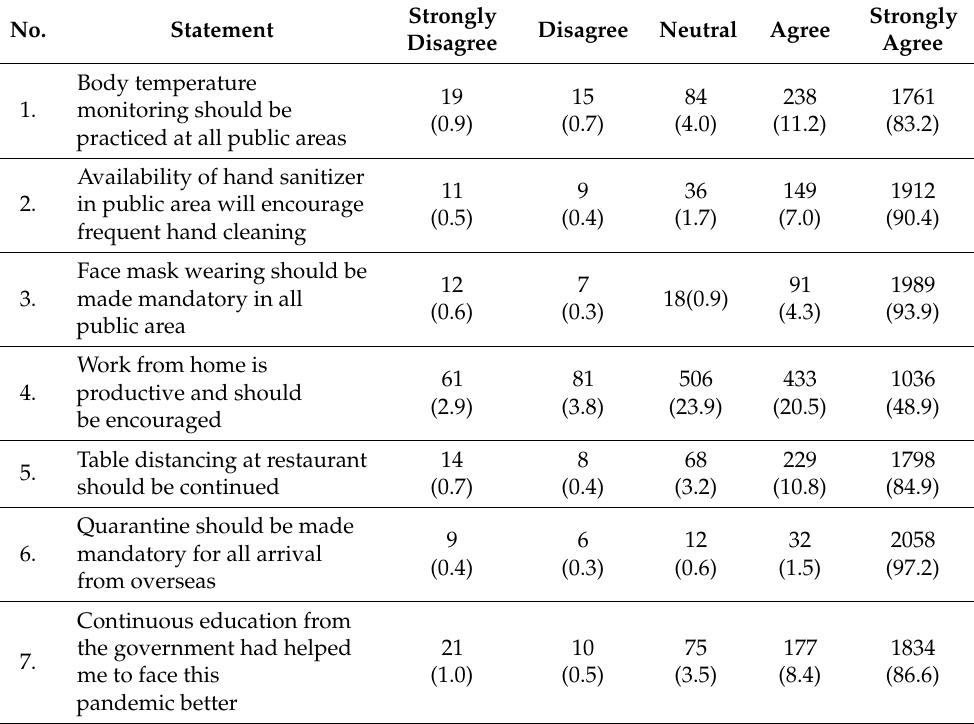
Table 7. Attitude towards new norm during the COVID-19 pandemic ( n = 2117).